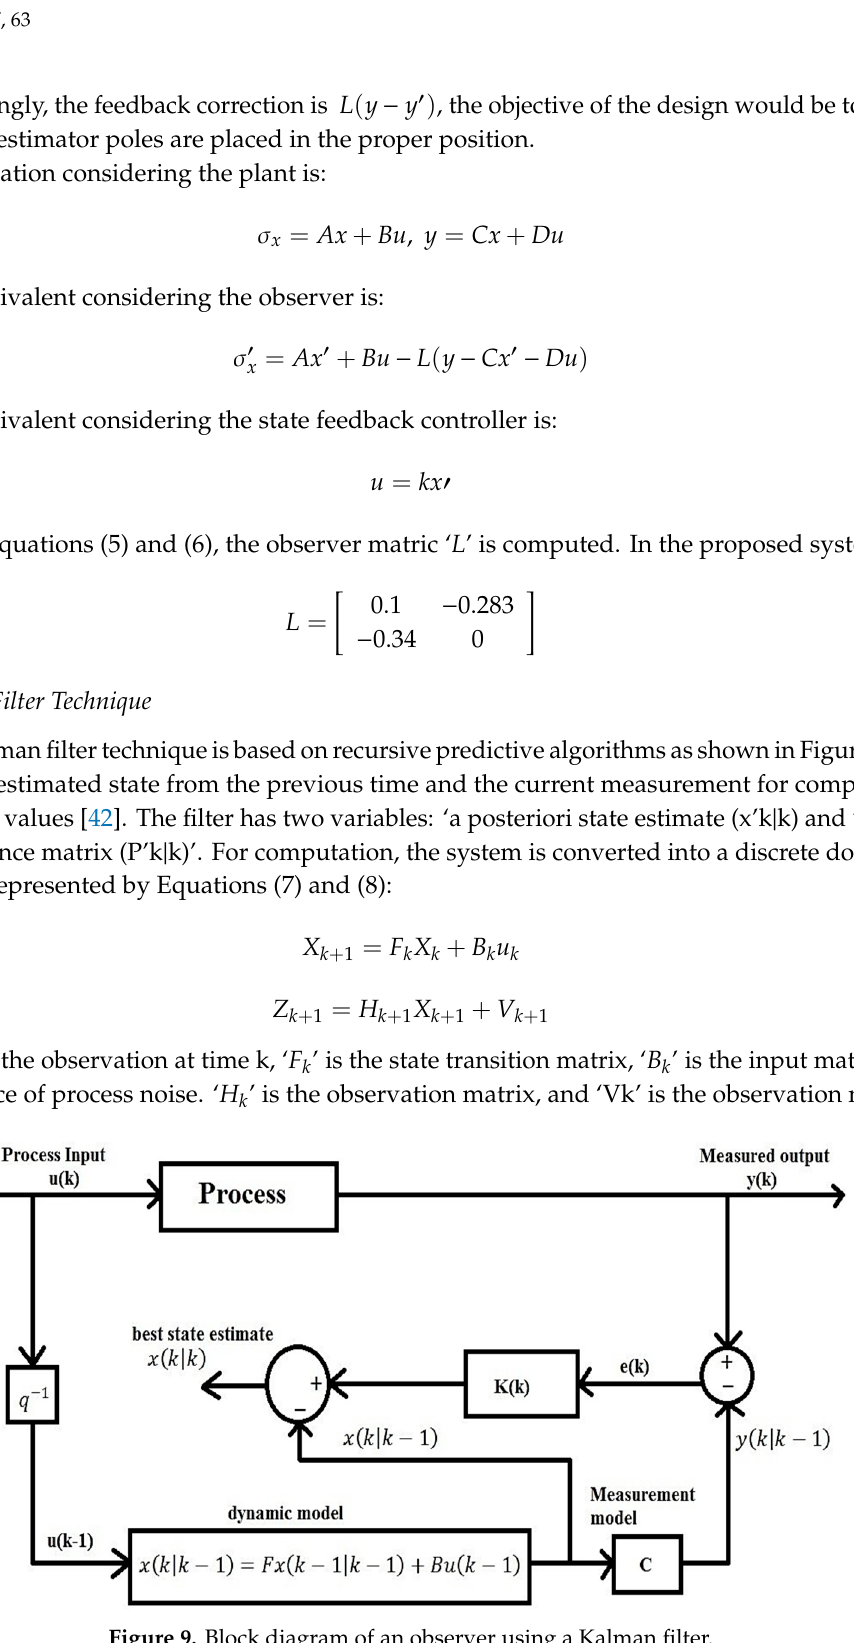
Figure 9. Block diagram of an observer using a Kalman filter.